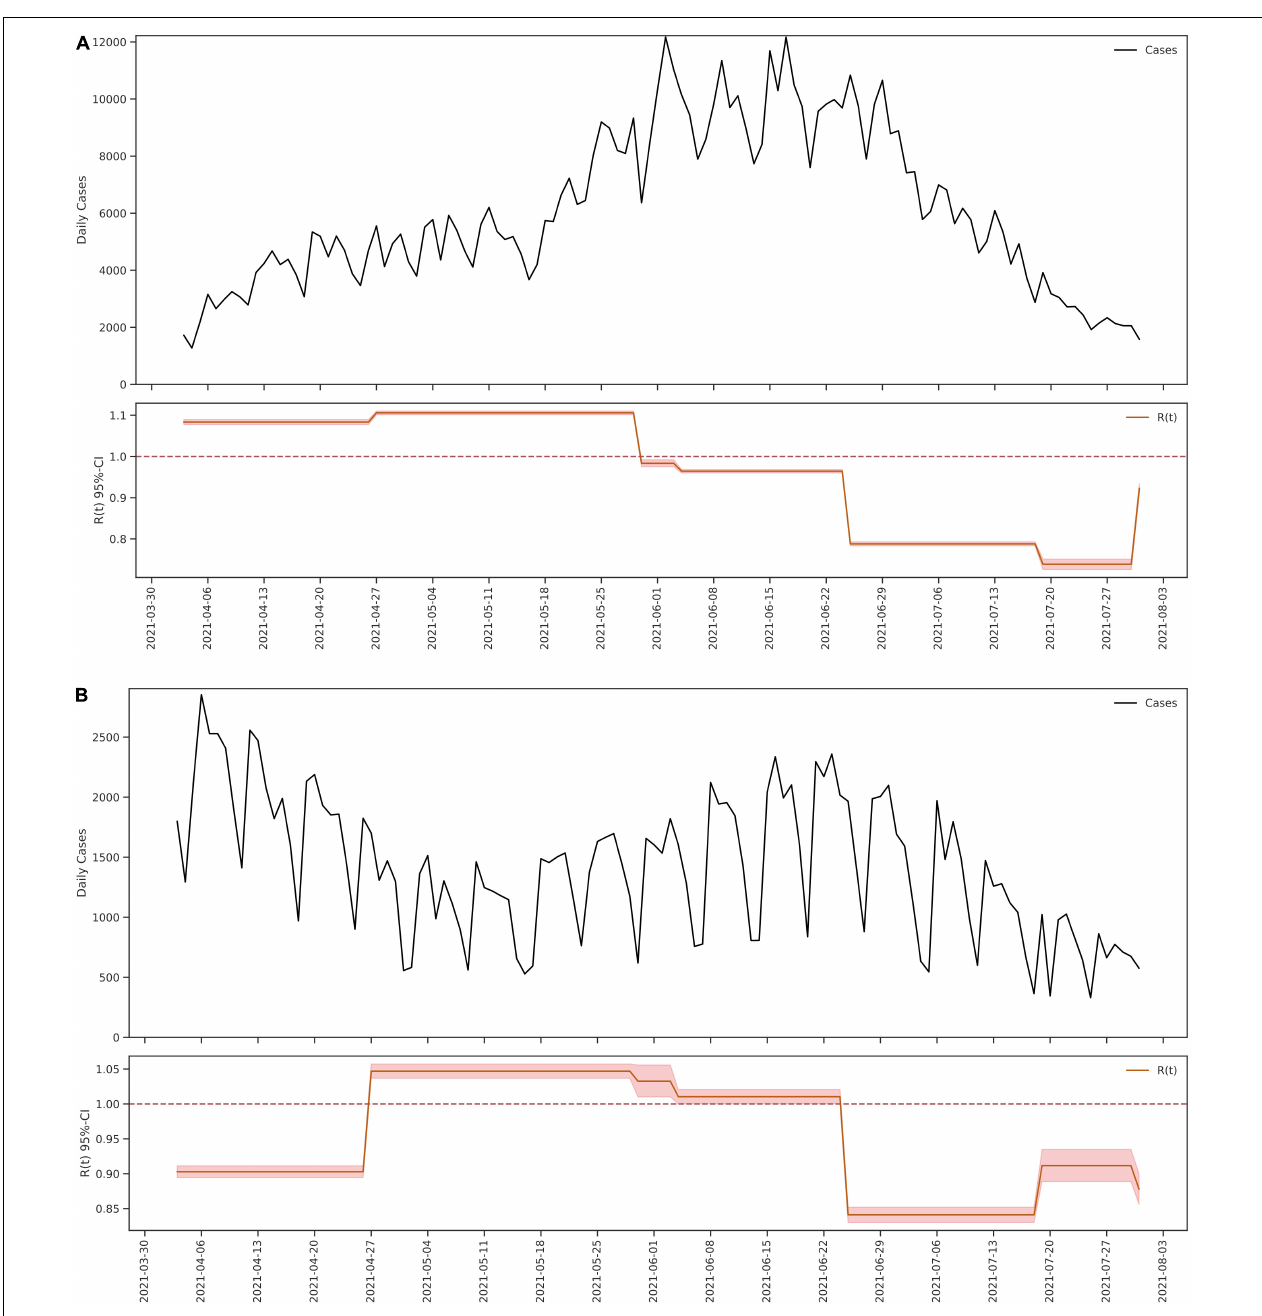
FIGURE 2 | Epidemic model of SARS-CoV-2 in Bogota and Medellin from 4 April 2021 to 31 July 2021. The figure shows the number of cases for SARS-CoV-2 reported daily and the value Rt calculated from 4 April 2021 to 31 July 2021, in the cites of Bogota (A) and Medellin (B) .